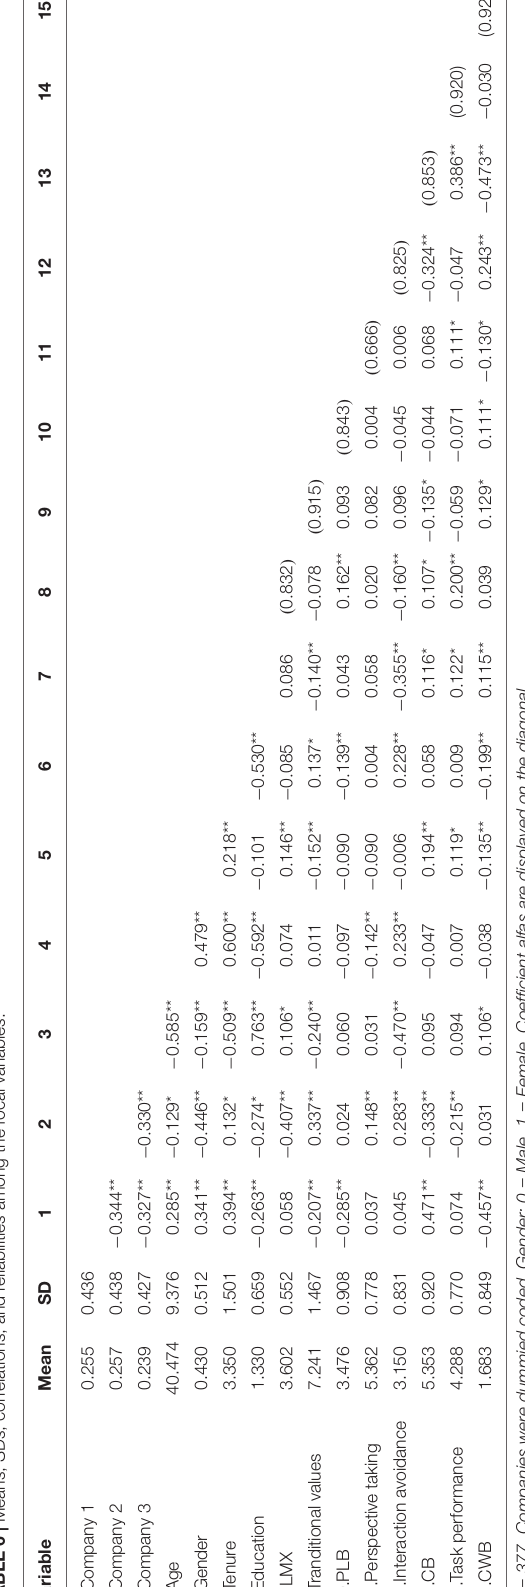
TABLE 5 | Confirmatory factor